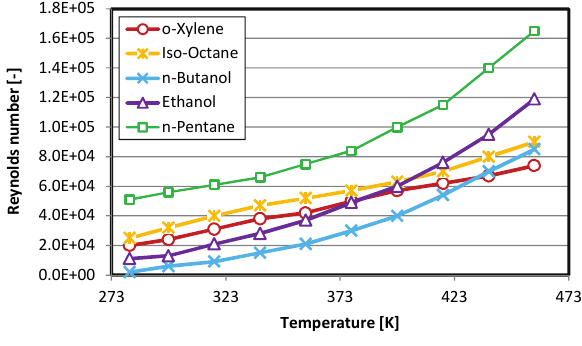
Fig. 3. Reynolds number of selected fuels